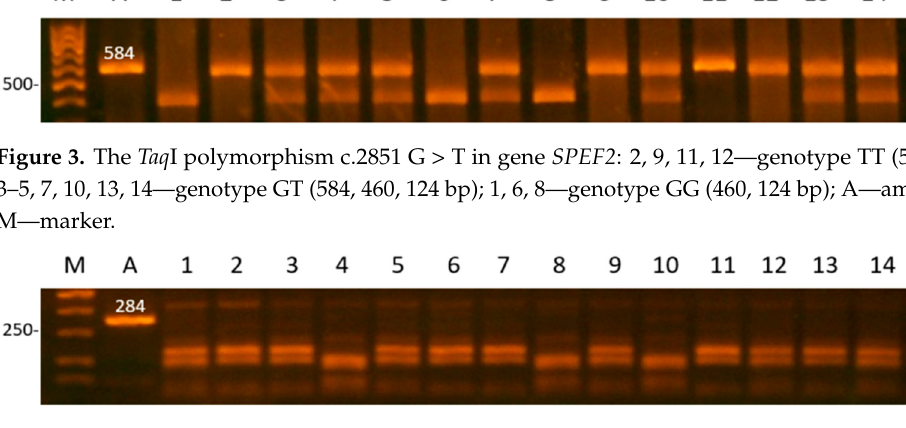
Figure 4. The Msp I polymorphism c.192 A > G in gene IHNA : 1–3, 5 ‐ 7, 9, 11–14—genotype AG (123, 95, 79, 44, 31 bp); 4, 8, 10—genotype GG (95, 79, 44, 31bp); A—amplicon; M—marker. Table 4. Distribution of semen quality traits by genotypes FSHR , INHA , INHAB , TNP2 and SPEF2 genes genotypes in Russian Holstein bulls.